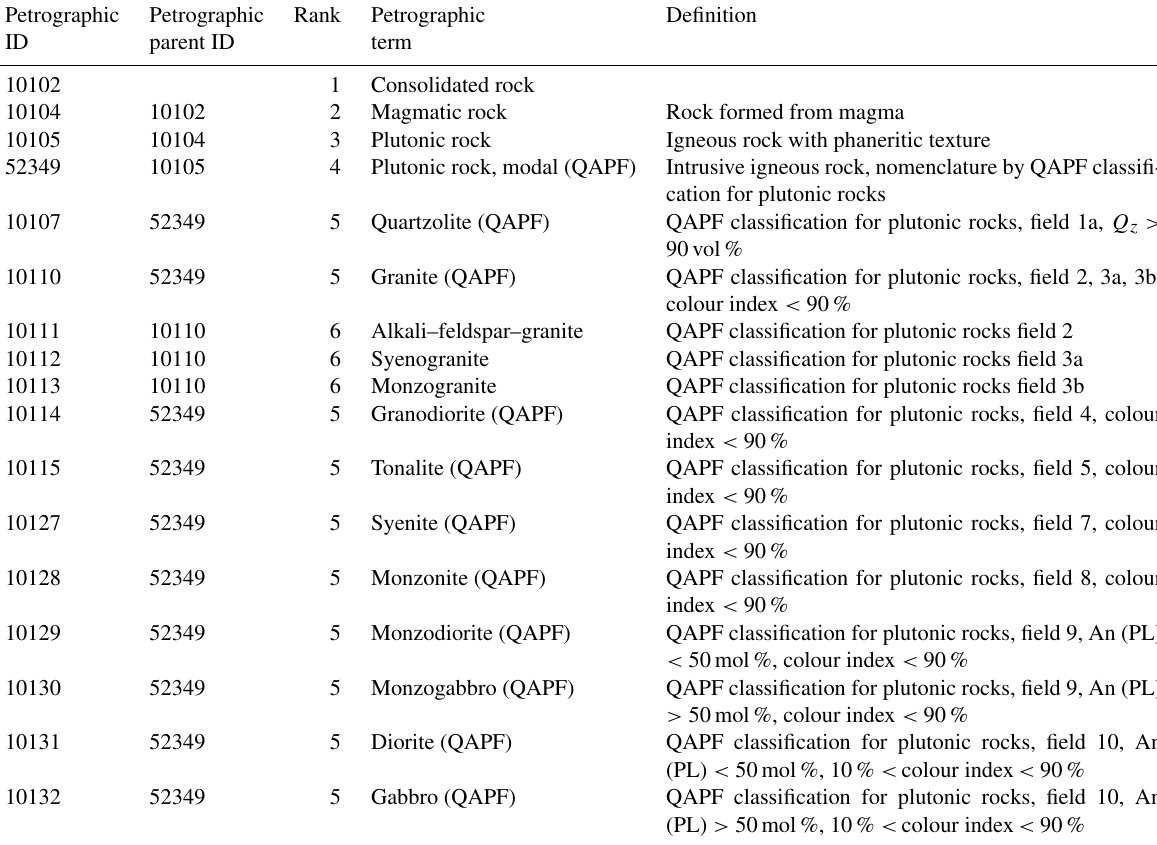
Table 1. Excerpt from the rock classification table used for P 3 . Different ranks and their interconnection by petrographic ID and petro- graphic parent ID as well as their connection to international definitions as indicated. QAPF: quartz–alkali feldspar–plagioclase–foids; PL: plagioclase (Le Maitre and Streckeisen, 2003).